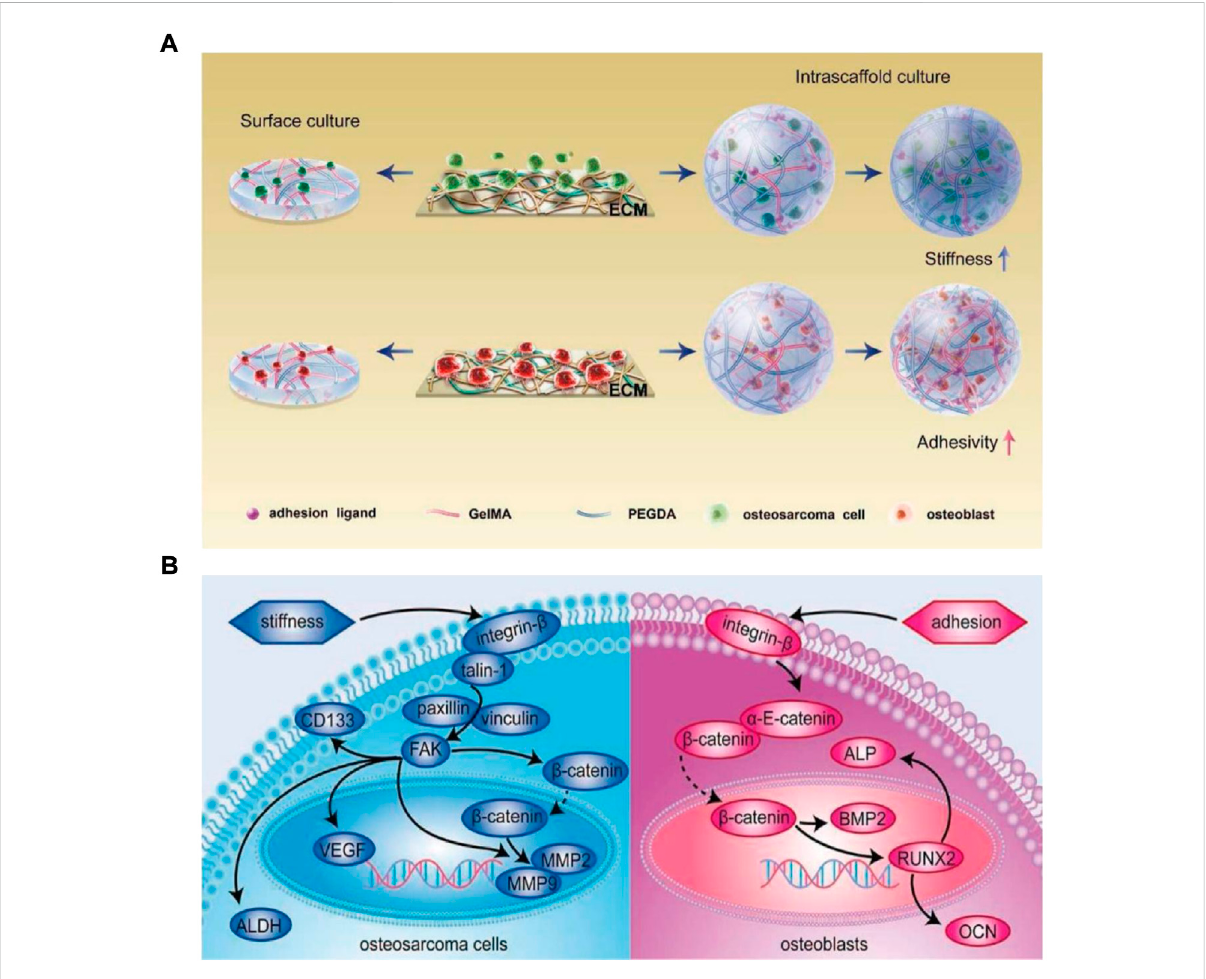
FIGURE 5 (A) Schematicillustrationofvariousanchorage-independentosteosarcomacellsandanchorage-dependentosteoblastsresponsestoadhesive activity and stiffness of scaffold (B) Respond of osteoblasts and osteosarcoma cell ’ s mechanisms to stiffness and adhesion ligands of ECM, respectively.ECM ’ sstiffnessandnotthematrixadhesionin fl uencesthegrowthofosteosarcomacellsbyregulatingtheintegrin-inducedFAsignaling pathway, while osteoblasts are primarily in fl uenced by ECM adhesion ligands via the integrin-induced AJ signaling pathway modulation.